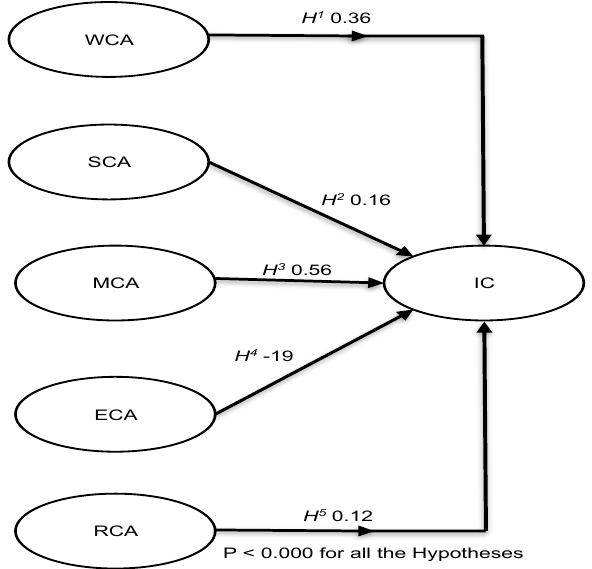
Empirical findings of CSR factors influencing the increased competitiveness of